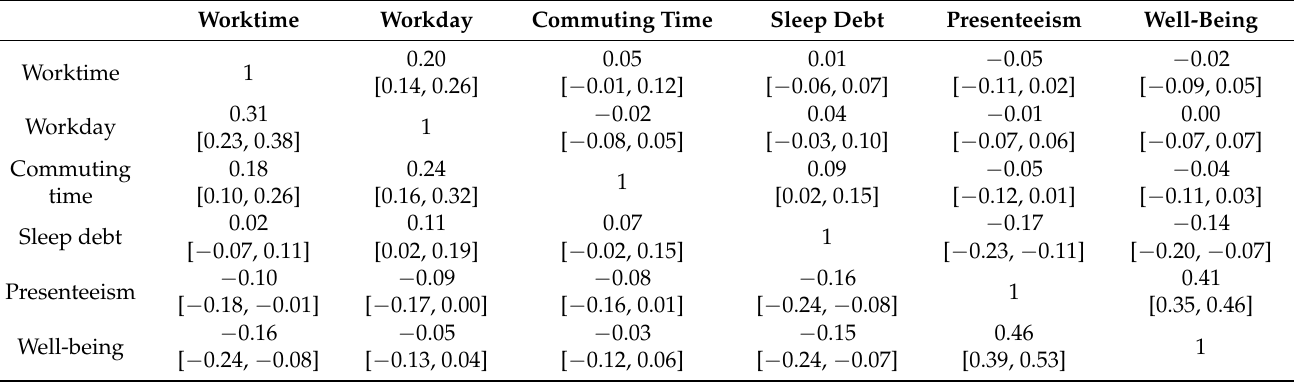
Table 3. Correlation matrix for SEM variables (above: full-time workers; below: part-time workers).